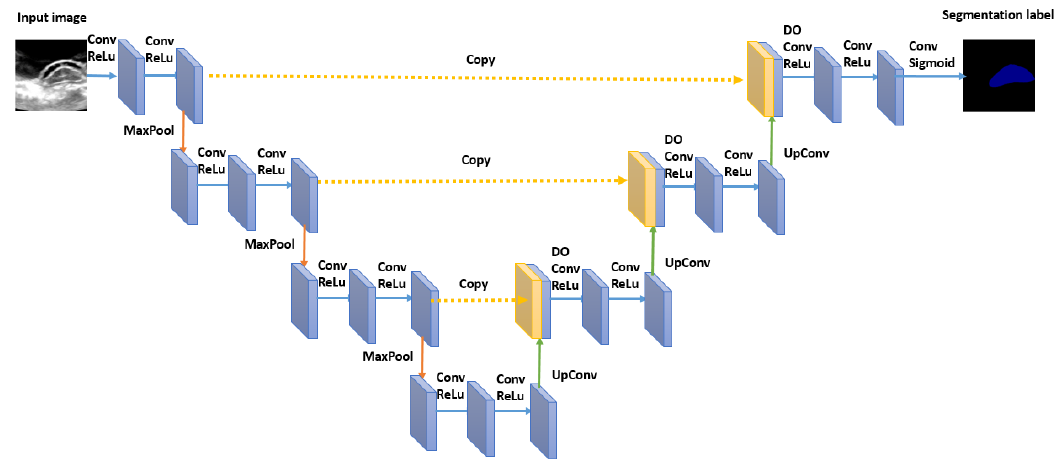
Figure 5. Spinal Cord semantic segmentation using U-Net architecture.